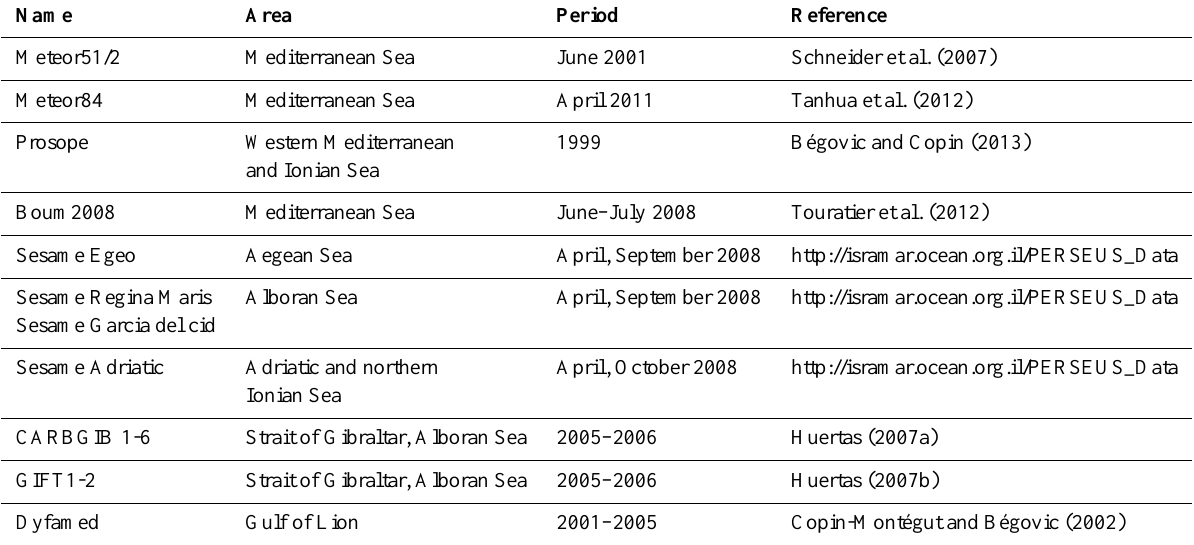
Table 1. List of available alkalinity data sets for the Mediterranean